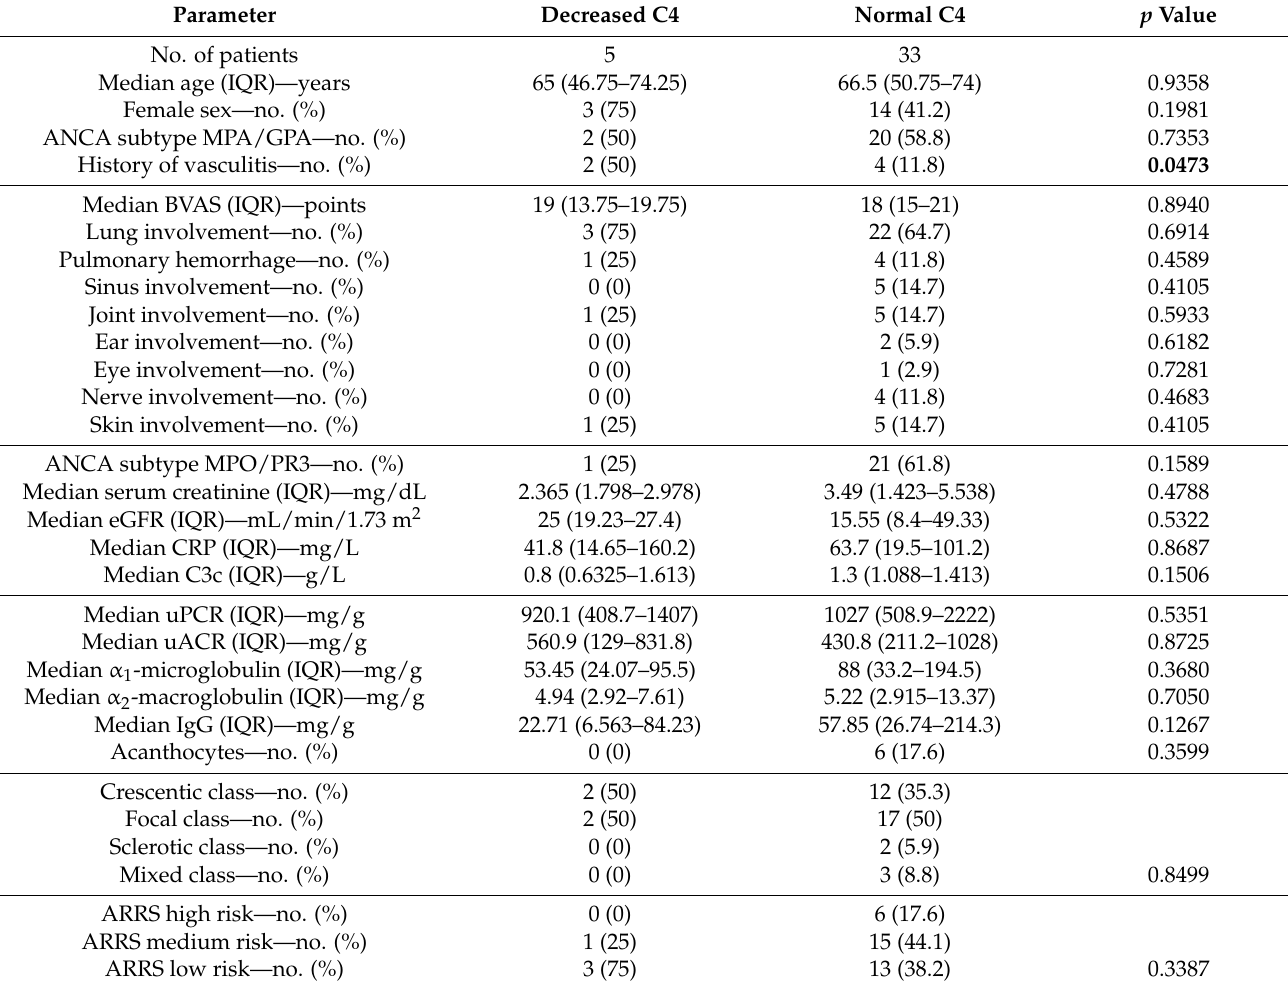
Table 3. Baseline patient characteristics according to circulating C4 levels (normal range: 0.15–0.57